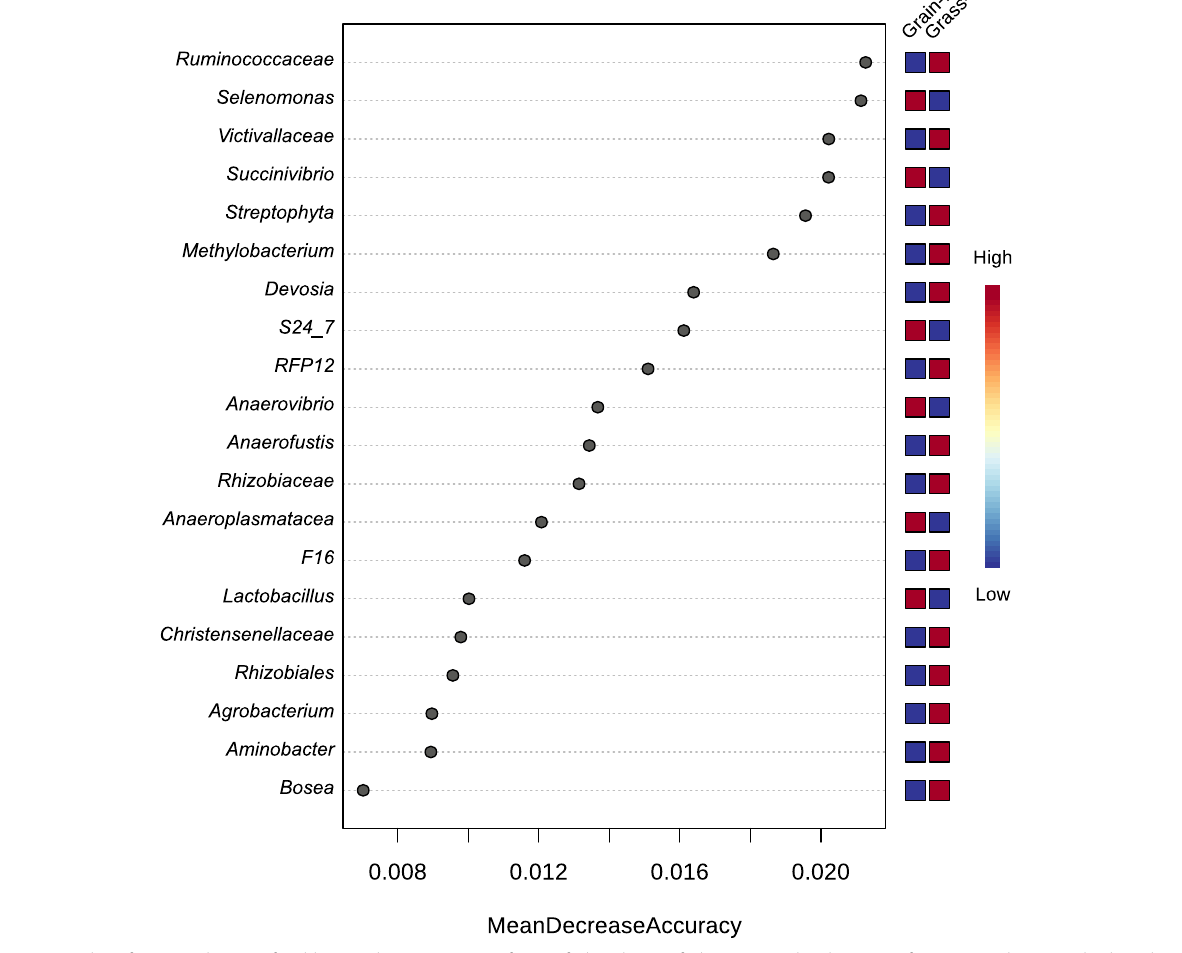
Fig. 3 Random forest analysis on fecal bacterial communities of grass-fed and grain-fed Angus cattle. The y-axis, from top to bottom, displays